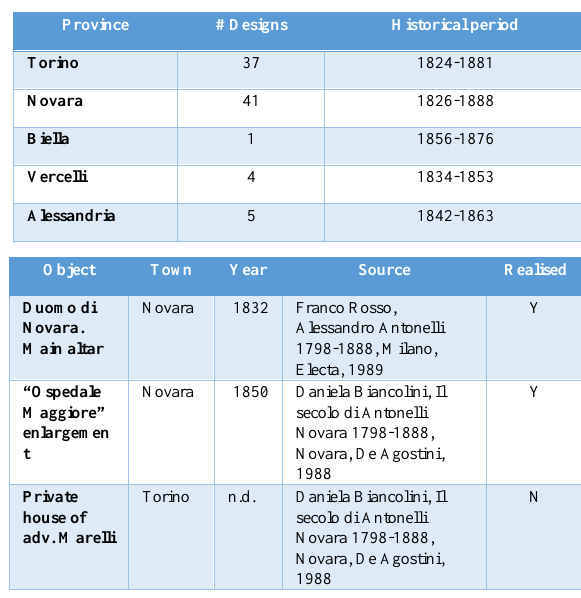
Figure 2. Attribute tables at national (up) and regional (low) level